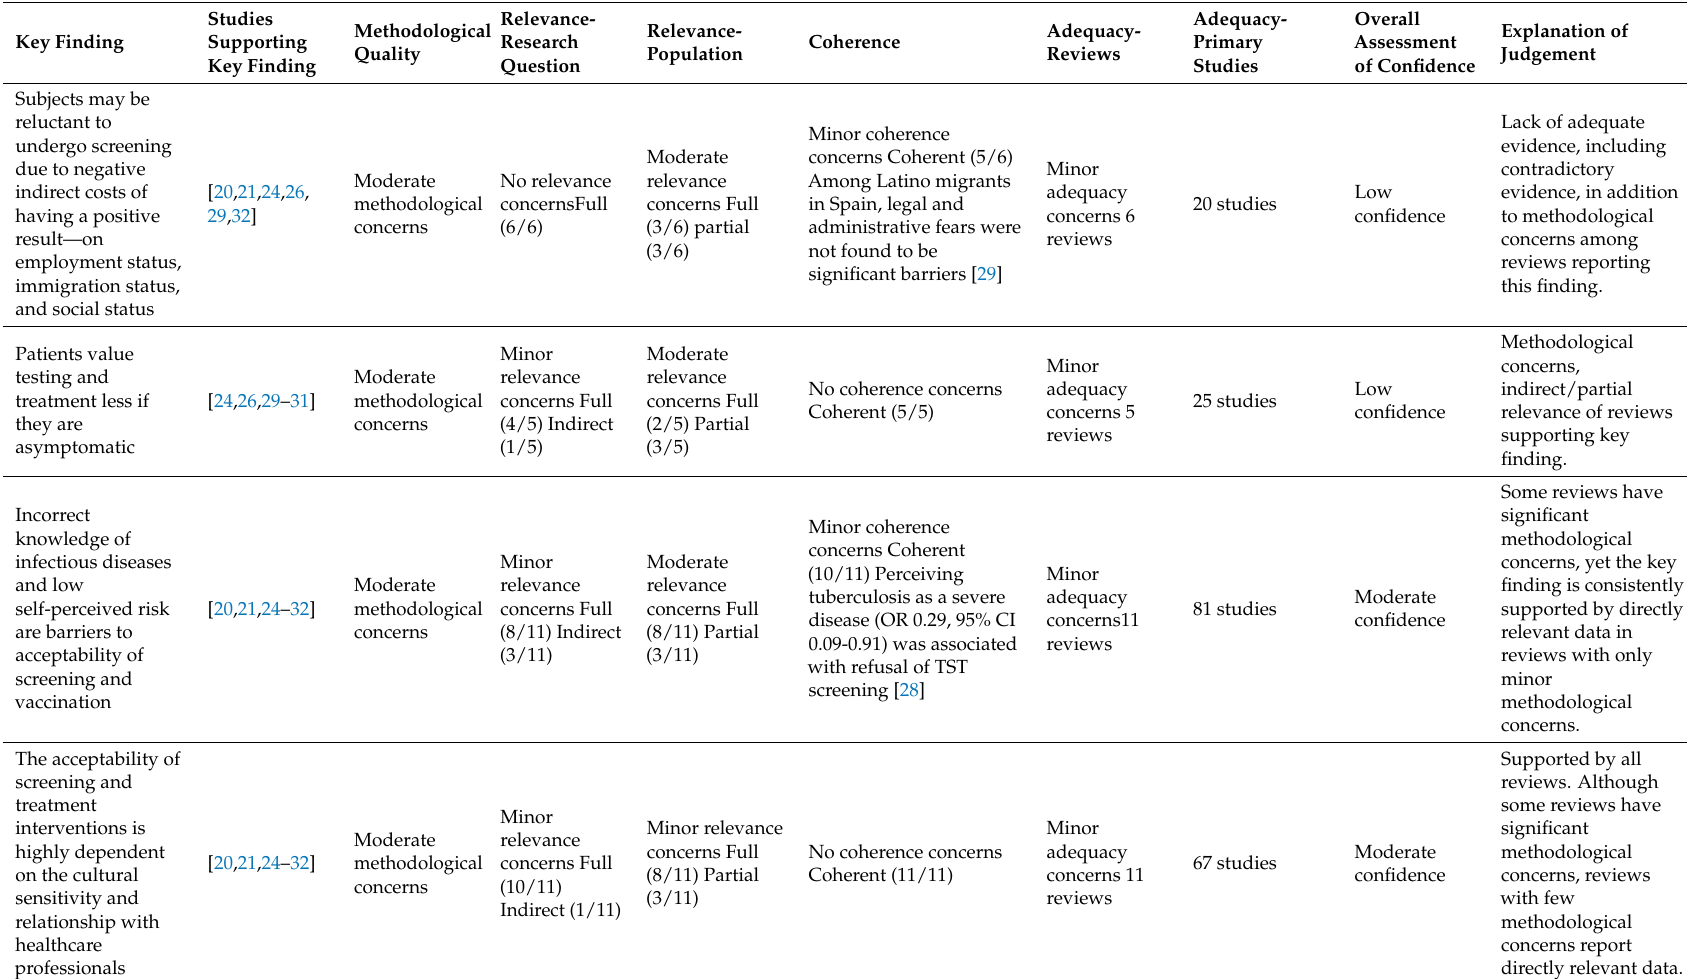
Table 3. GRADE CERQual Evidence